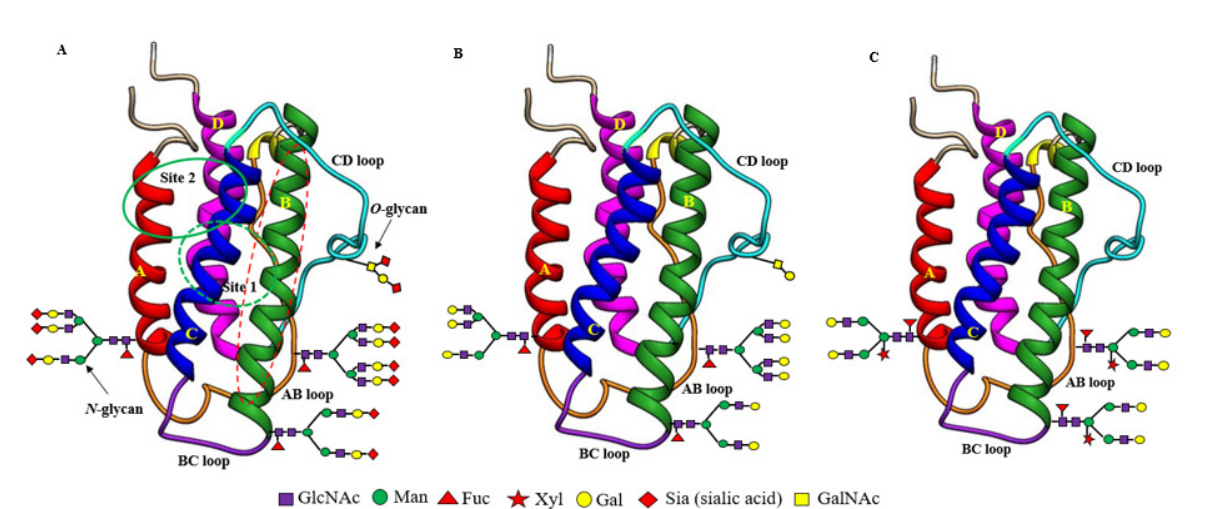
Figure 1. Structural differences between recombinant sialylated rhuEPO M ( A ), enzymatically pre- pared asialo-rhuEPO E ( B ) and plant-produced asialo-rhuEPO P ( C ). Their protein structures are the same with two separate hematopoietic receptor (EPOR) 2 binding sites (site 1 marked by the green dotted circle at the back side of EPO; site 2 marked by a solid green circle at the front side of EPO). Both binding sites are present distal to the carbohydrate chains. Helix B marked by the red dotted oval is proposed to be involved in EPO-mediated protective functions. All three types of EPO differ with respect to the structure of their N -glycan chains. RhuEPO M bears sialic acid residues (red diamond) as terminal sugar on bi-, tri- and tetrantennary N -glycans while asialo-rhuEPO E lacks sialic acid residues and contains β 1,4-galactose residues (yellow circles) as terminal sugars. Asialo-rhuEPO P lacks terminal sialic acid residues like asialo-rhuEPO E . In addition, asialo-rhuEPO P bears biantennary N -glycan chains with plant-specific xylose and fucose residues and lacks O -glycan chain.